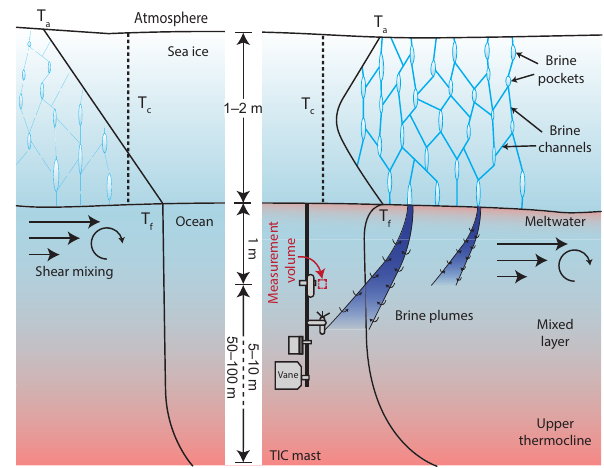
Figure 7. To the left is an early spring situation in which the up- per ocean is near freezing, and temperature in the ice is still be- low the critical temperature T c , which must be exceeded for gravity drainage to occur. When the atmosphere warms the ice, permeabil- ity of the sea ice increases, and gravity drainage can occur. The brine plumes are triggered by meltwater below the ice, by directly exposing brine pockets, or by elevating the freezing point tempera- ture T f at the interface. The TIC mast is shown for reference, with measurement volume at 1m below the